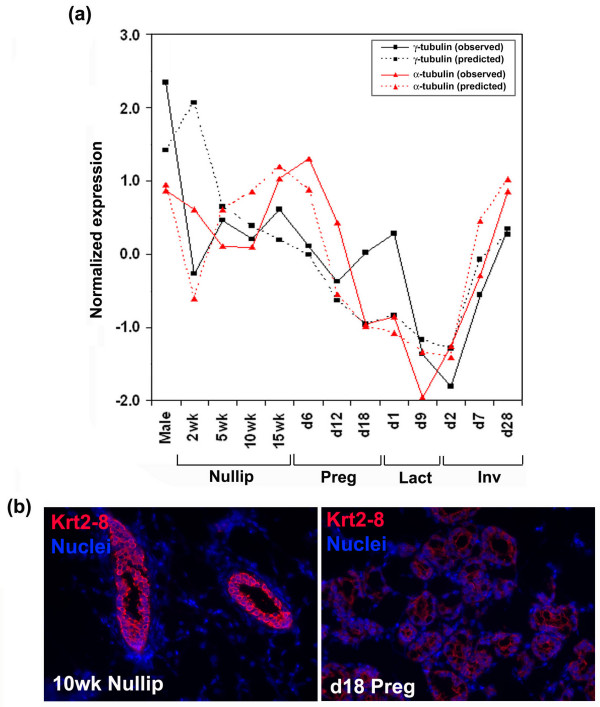
Tubulin and cytokeratin 8 expression during mammary gland development. (a) Predicted (dashed lines) and observed (solid lines) normalized expression for α-tubulin and γ-tubulin during mammary gland development. A high correlation was found between observed expression profiles and predicted profiles calculated based on changes in cell compartment sizes. (b) Immunofluorescence staining of cytokeratin 8 (Krt2-8) showing downregulated expression in the mammary epithelium at d18 of pregnancy compared to 10 wk of nulliparous develoment.